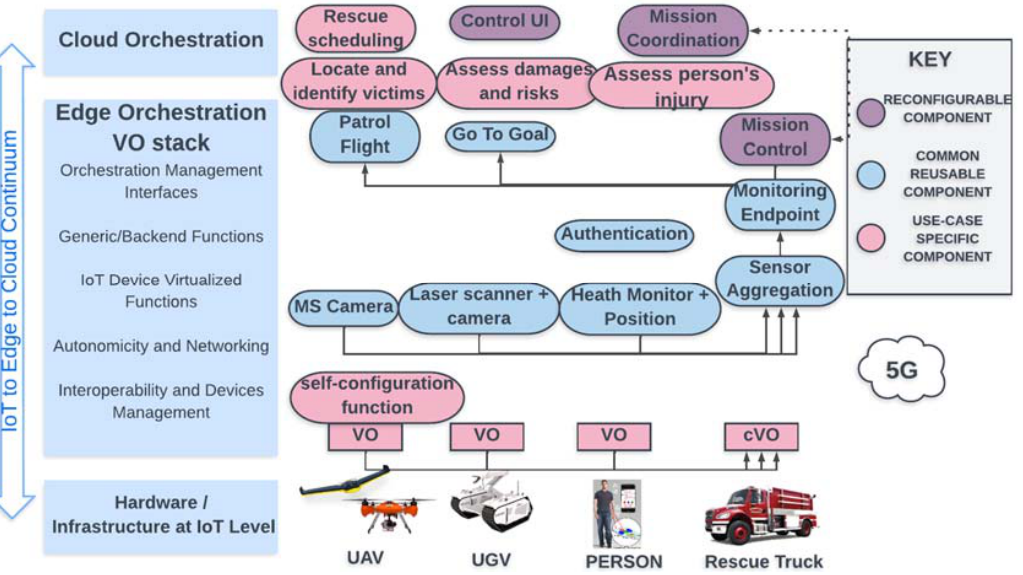
Figure 3. VOStack mapping to SAR application scenarios. Hyperdistributed applications are formed of multiple components that are either use ‐ case specific or generic or reconfigurable. These components are placed on different levels of the IoT ‐ to ‐ edge ‐ to ‐ cloud continuum and based on their functionalities are part of the different layers of the VOStack.